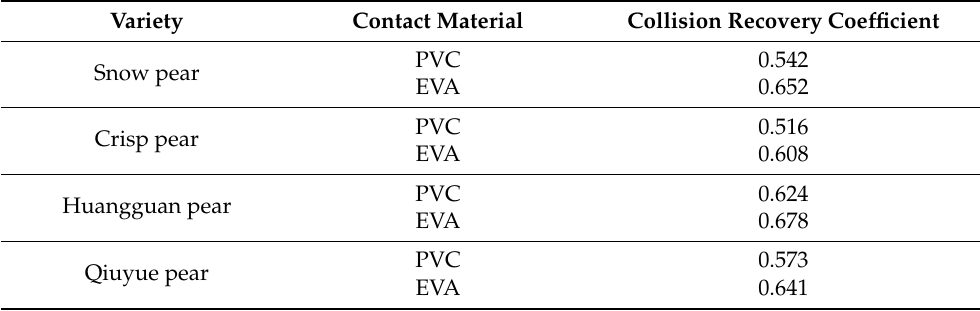
Table 5. Simulated values of collision recovery coefficients between typical pears and materials. Variety Contact Material Collision Recovery Coefficient Snow pear